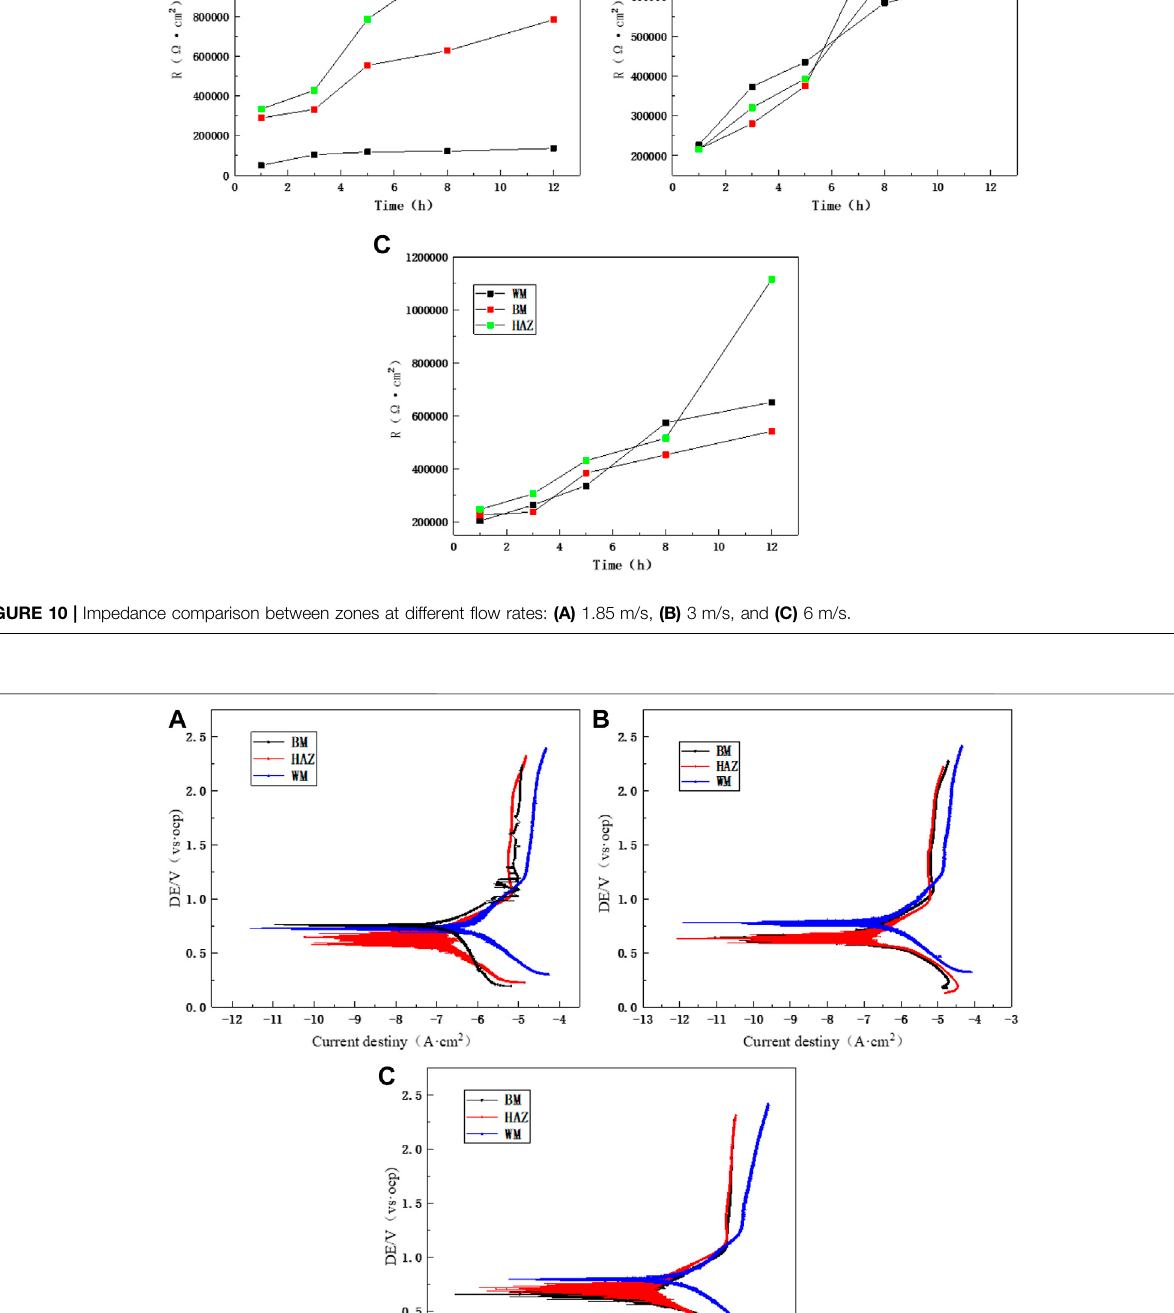
Frontiers in Materials |